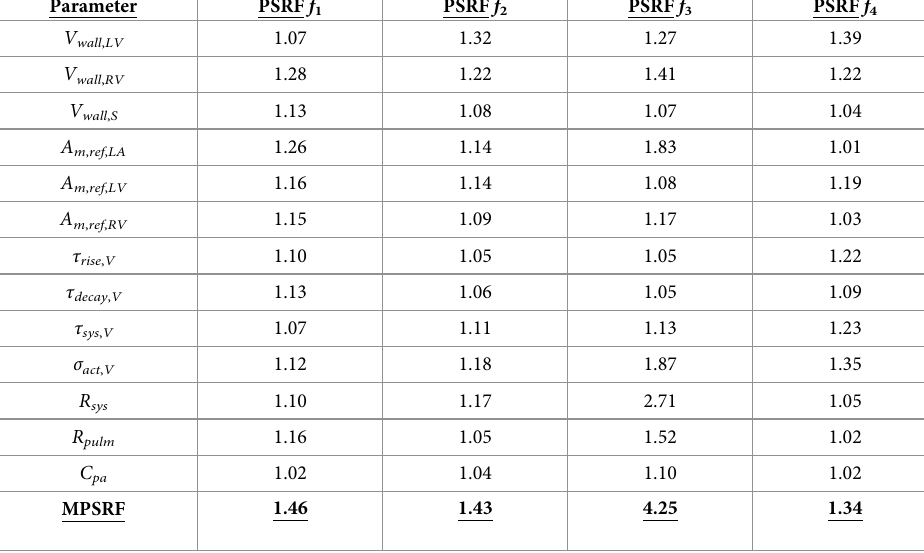
Table 3. Potential scale reduction factor (PSRF) and multivariate PSRF (MPSRF) values calculated for each parameter and the 12 initializations of MCMC, respectively.